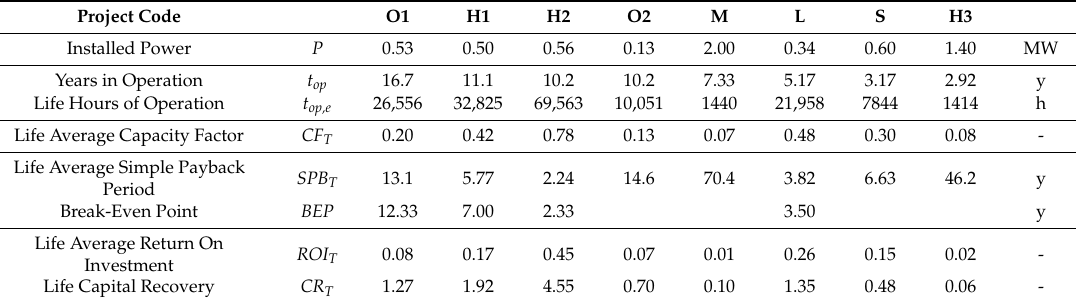
Table 2. The Athens CHP projects’